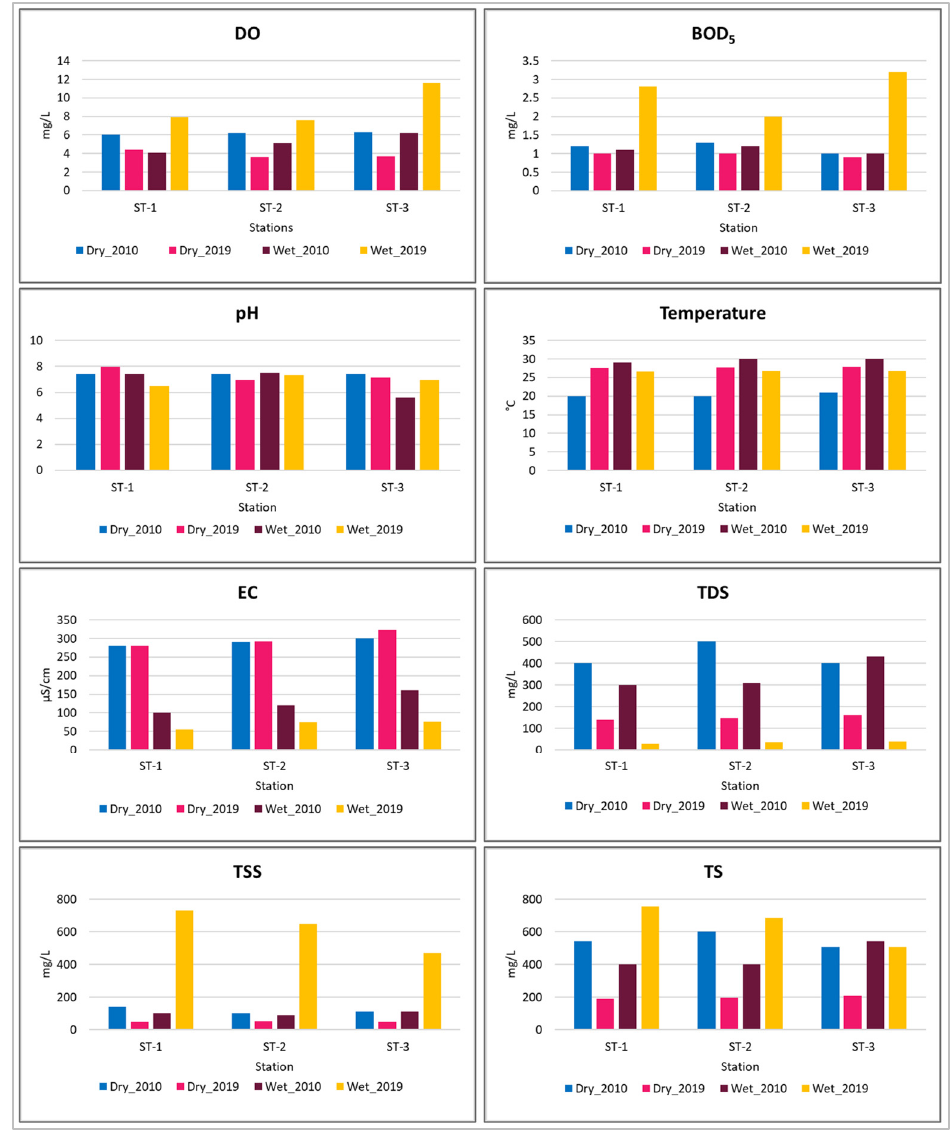
Figure 3. Seasonal and spatial variations of WQPs in 2010 and 2019.